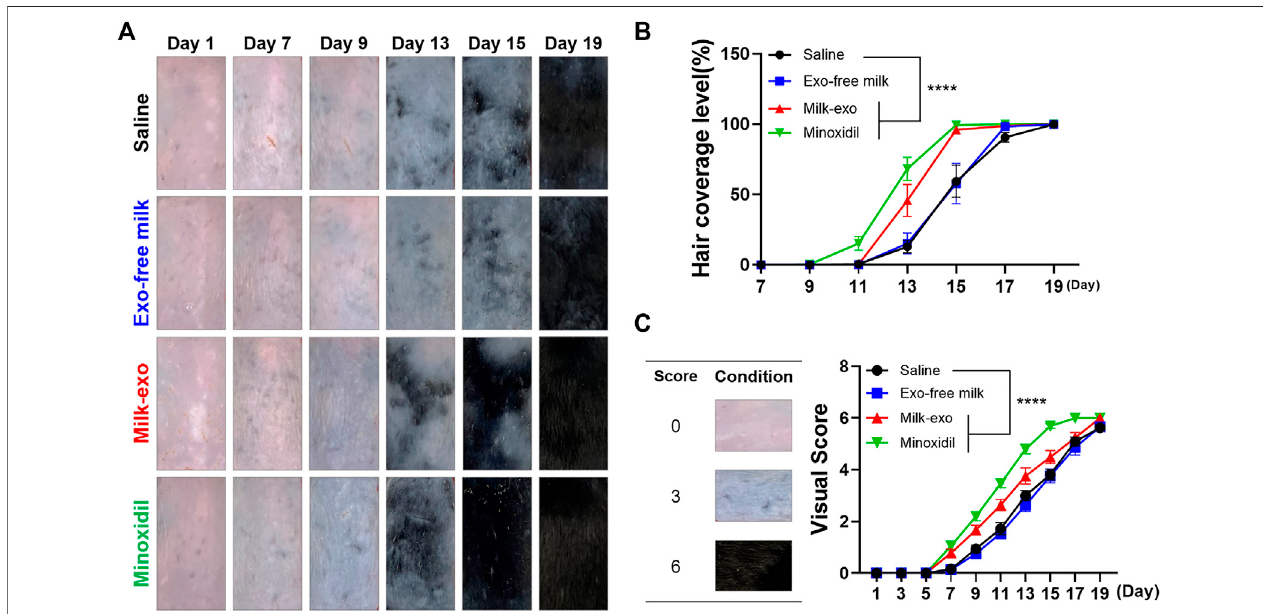
FIGURE5| HairregenerationeffectofmilkexosomesinC57BL/6mice. (A) Representativeimagesofhairregenerationafterintradermalinjectionofsaline,Exo-free milk, Milk-exo (200 μ g per 100 μ L), and topical application of 2.5% minoxidil. Each reagent was administrated every other day for 3 weeks. (B) Quanti fi cation of hair coverage level ( n = 8, **** p < 0.0001 versus saline, two-way ANOVA, Dunnett ’ s multiple comparisons test). (C) Mean visual score measurements ( n = 8; **** p < 0.0001, two-way ANOVA, Dunnett ’ s multiple comparisons test).